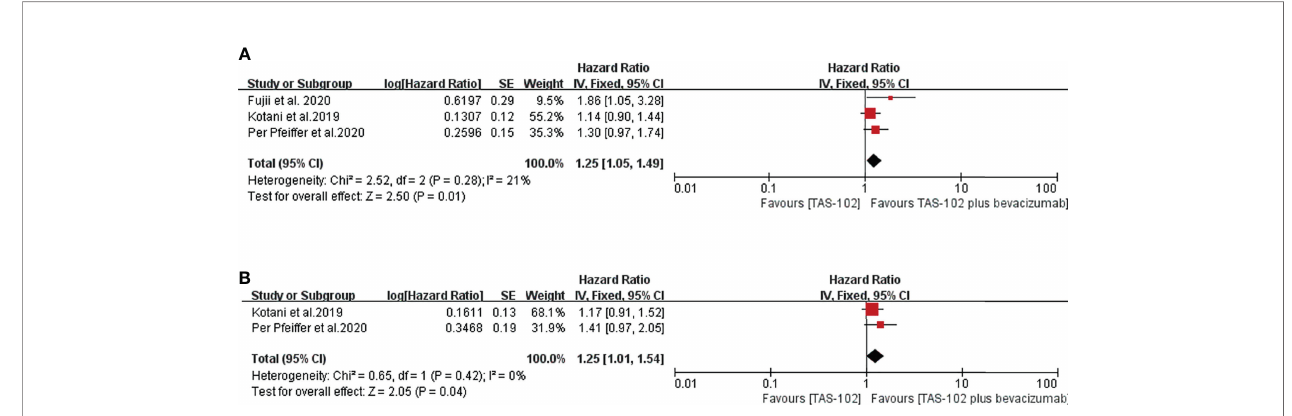
FIGURE 2 | Forest plot of the meta-analysis comparing TAS-102 plus bevacizumab and TAS-102 in mCRC patients in terms of survival outcomes based on the Cox hazard model. (A ) Overall survival. (B) Progress free survival. Horizontal lines represent 95% con fi dence intervals (CIs). df, degrees of freedom.